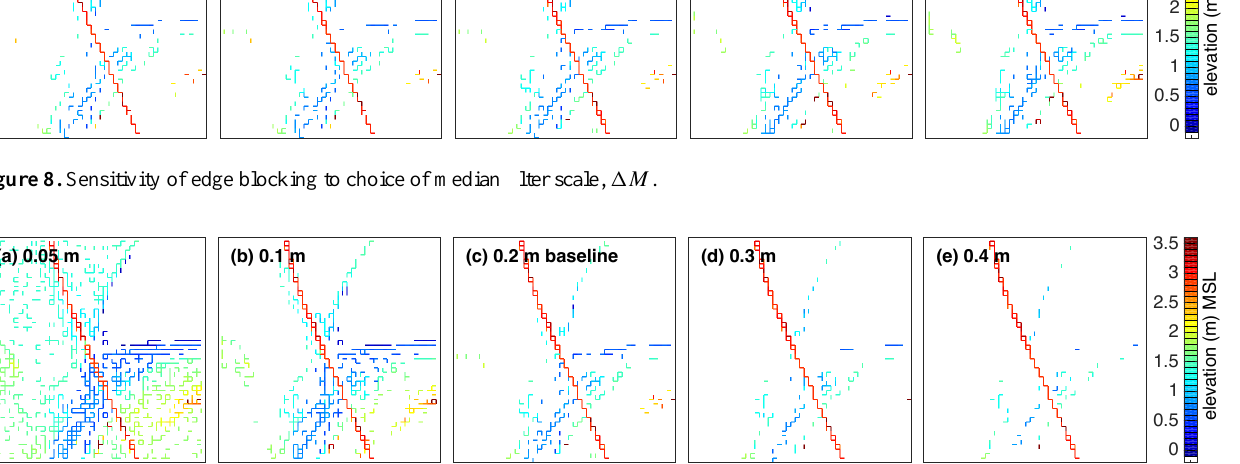
Figure 9. Sensitivity of edge blocking to choice of object height cutoff (cid:49)h